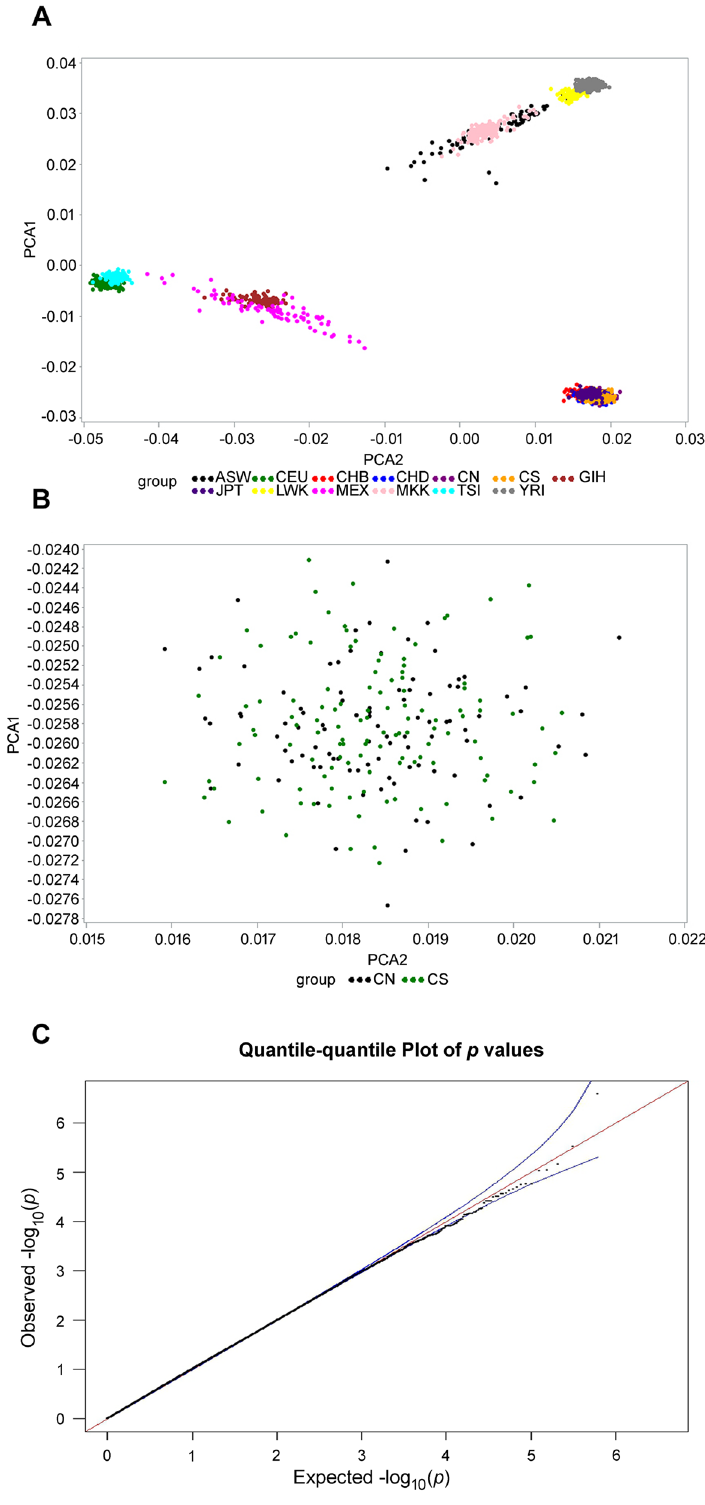
Figure 1. Multidimensional scaling analysis. ( A ) The results of multidimensional scaling analysis of the GWAS samples with HapMap populations, represented with principal component analysis (PCA) plot. ( B ) The results of multidimensional scaling analysis of the GWAS sample only. ( C ) Quantile (Q)–Quantile (Q) plot of the P value in Cochran–Armitage trend test. The lambda (λ) value is 1.01. CA case, CN control, GWAS genome-wide association